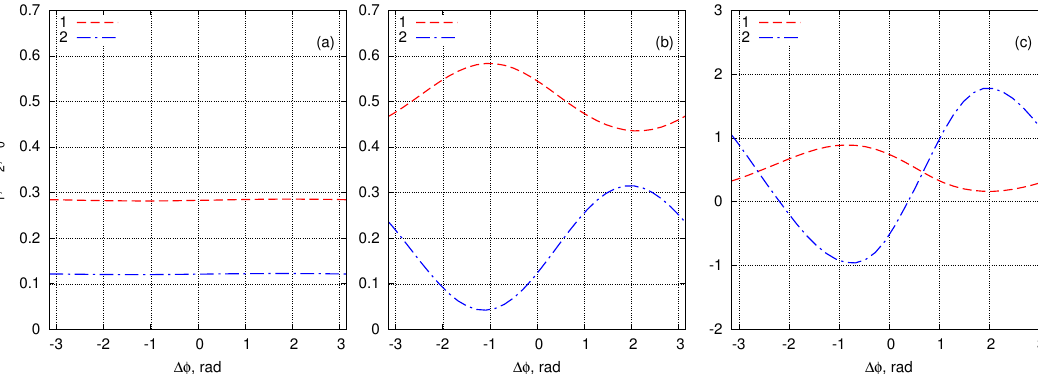
Figure 12. Space shifts of the breathers depending on the relative phase ∆ φ for different wave steepnesses and the relative velocity ∆ V = 8%. Panels ( a – c ) correspond to experiment 1 , experiment 2 , and experiment 3 , respectively.